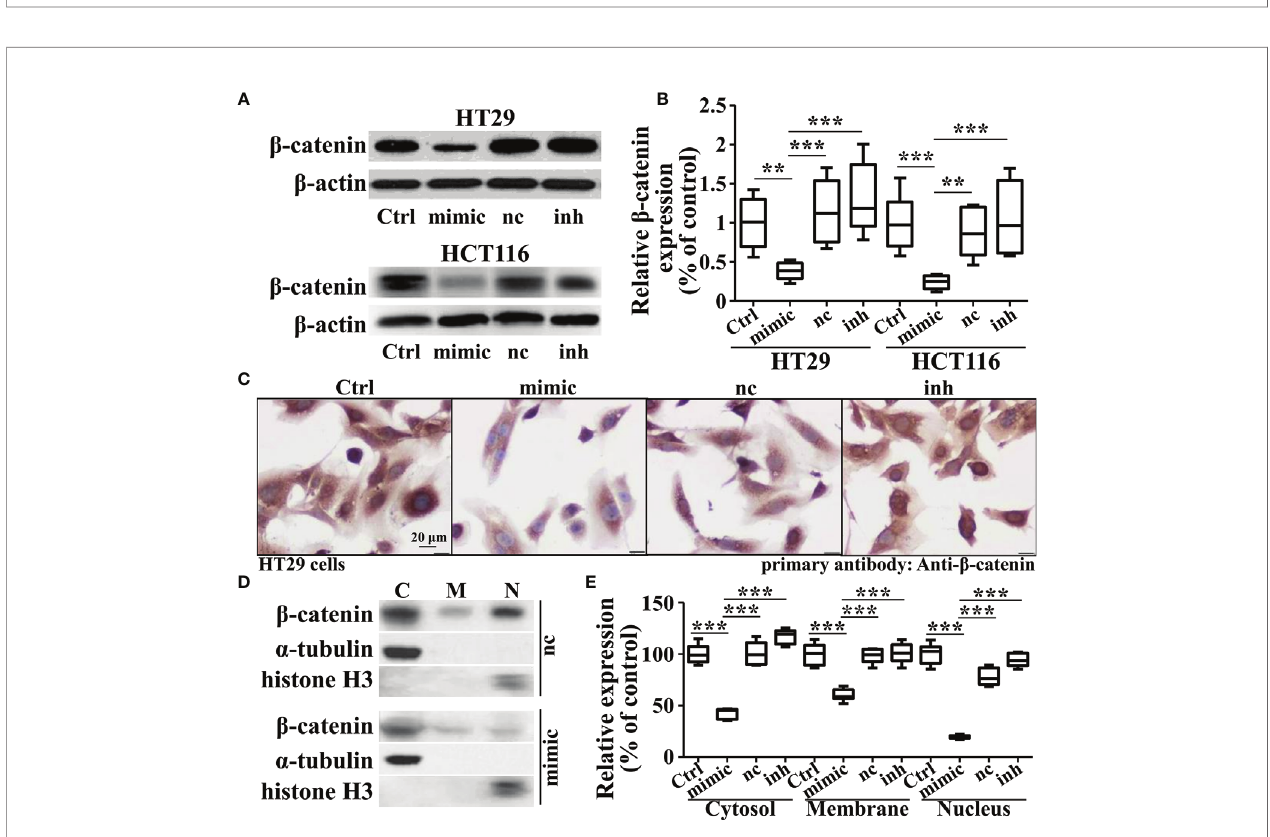
FIGURE 4 | Overexpression of miRNA-142-3p inhibits the expression levels and patterns of b -catenin in colorectal cancer cells. (A) Representative Western blot and (B) Summary of the expression of b -catenin when overexpressing or repressing miRNA-142-3p levels. (C) Immunohistochemistry analysis of HT29 cells after overexpressing or repressing miRNA-142-3p. Scale bar, 20 m m. (D) Representative Western blot and (E) Summary of the cytosolic, membrane and nuclear expression b -catenin after cell fractionation. All data are shown as means ± SD. ** and *** represent signi fi cant difference as p < 0.01 and 0.001,